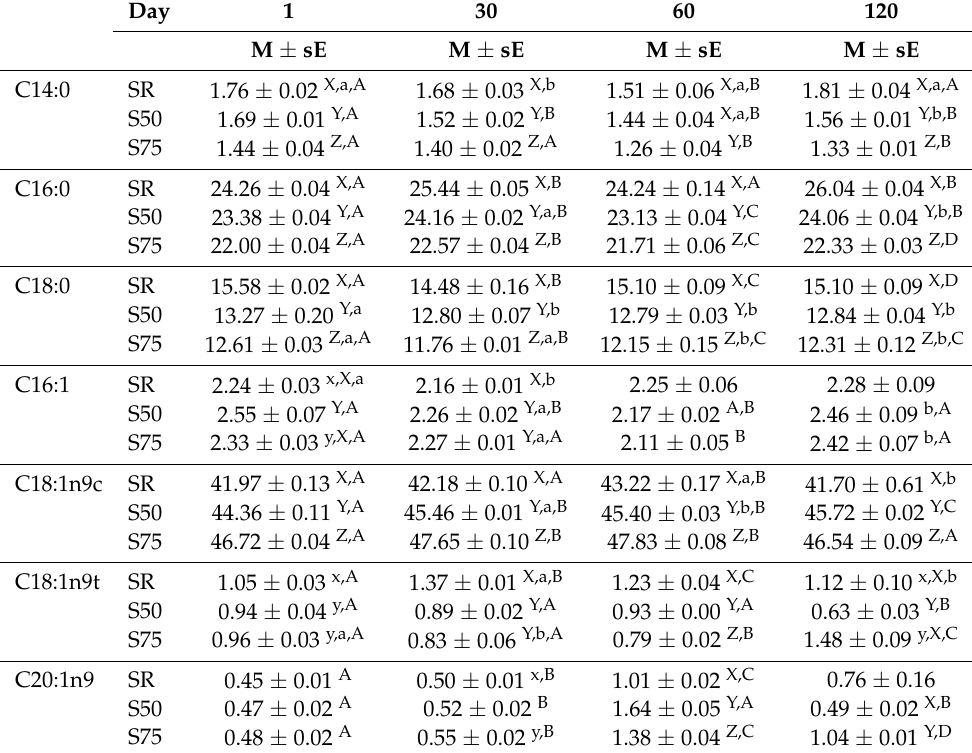
Table 2. Fatty acid composition (%) of three salami (SR, S50, and S75) during ripening.